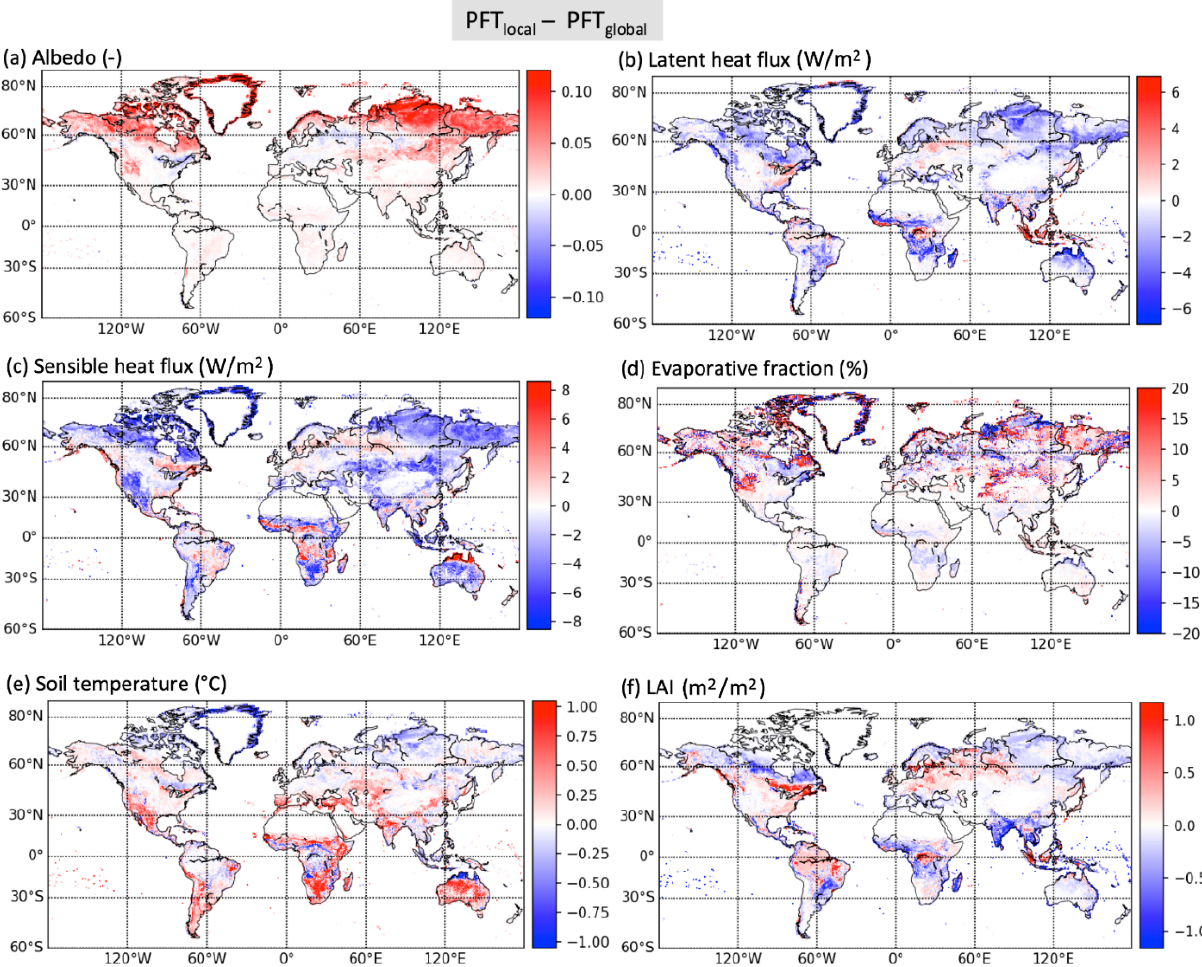
Figure B1. Differences in albedo (a) , latent heat flux (b) , sensible heat flux (c) , evaporative fraction d – latent heat flux/latent + sensible heat fluxes, soil surface temperature (e) and leaf area index (LAI, f ) simulated by the ORCHIDEE model between the new PFT and old PFT distributions for the annual mean of the year 2010 (same as Fig. 4 but for the annual